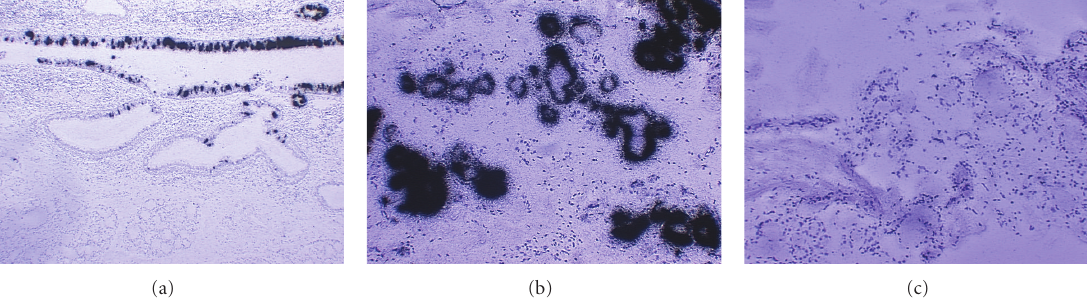
Figure 3: Mucins MUC5AC and MUC5B are two predominant mucins in the middle ear and Eustachian tube areas. (a) MUC5AC is typically expressed in the epithelial cells of the Eustachian tube. (b) MUC5B is predominantly expressed in the mucous cells of submucosal glands. (c) Control for in situ hybridization in (a) and (b). Note: Black dots indicate the mRNA transcripts for MUC5AC or MUC5B.